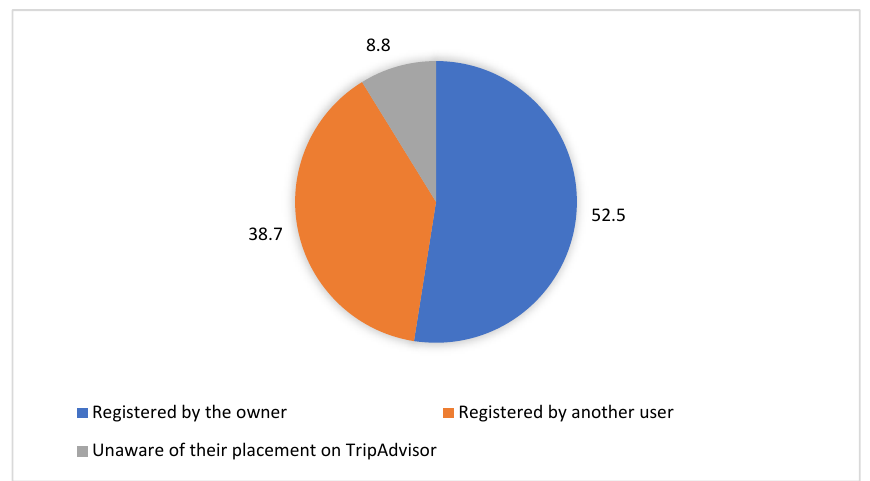
Figure 3. Type of registration in TripAdvisor (%).